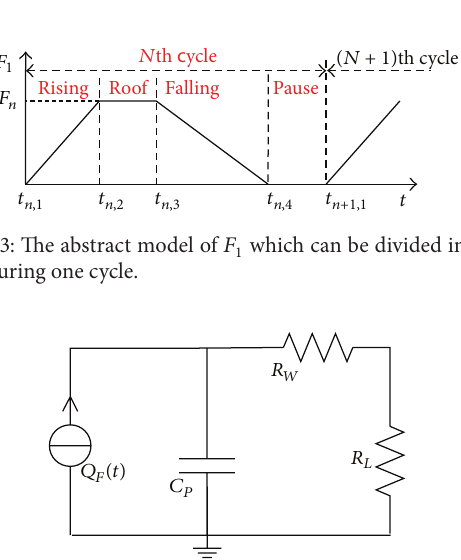
Figure 4: PVDF unit is connected with a resistive load.